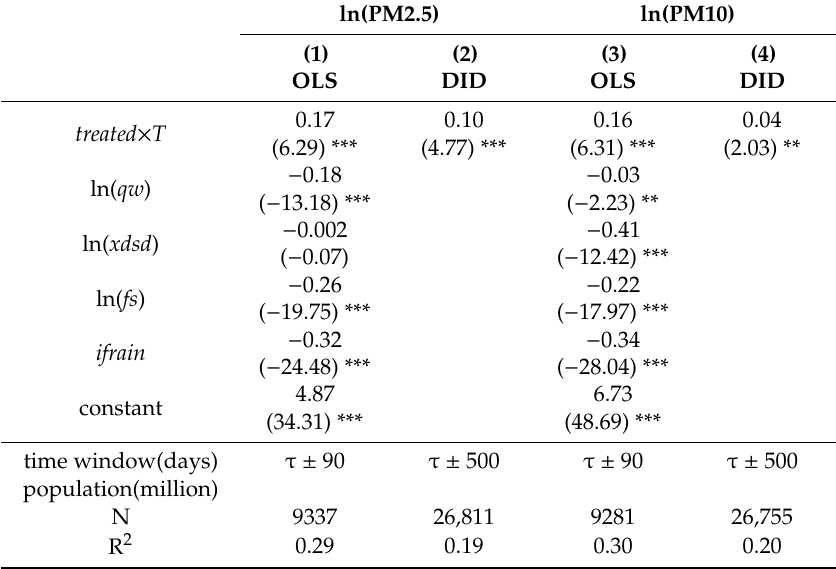
Table 9. Robustness check: estimation for PM2.5 and PM10